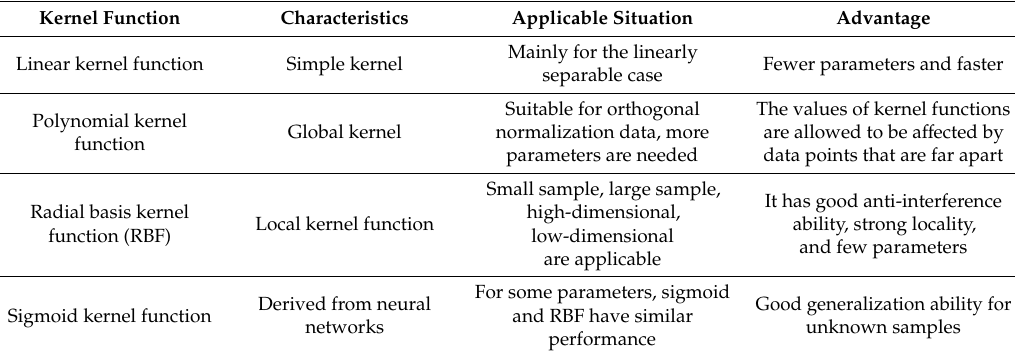
Table 1. Comparison of kernel